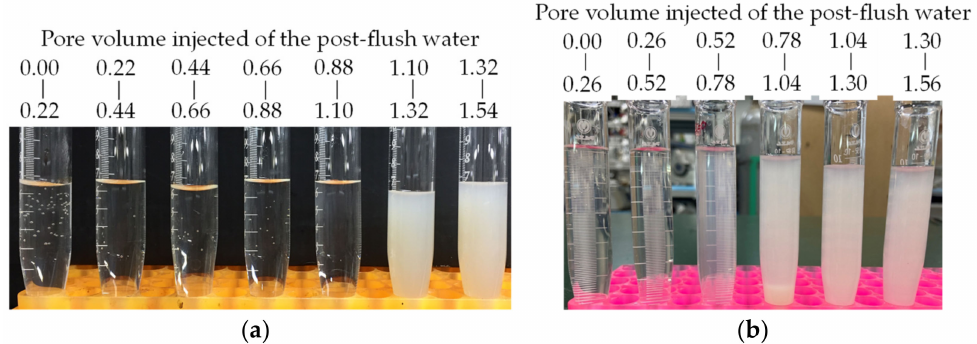
Figure 11. The photo images of the effluent collected from the cores during the post-flush water injection: ( a ) effluent from the core into which P. aeruginosa was injected with the carbon diox- ide nanobubble medium; ( b ) effluent from the core into which the non-inoculated blank medium was